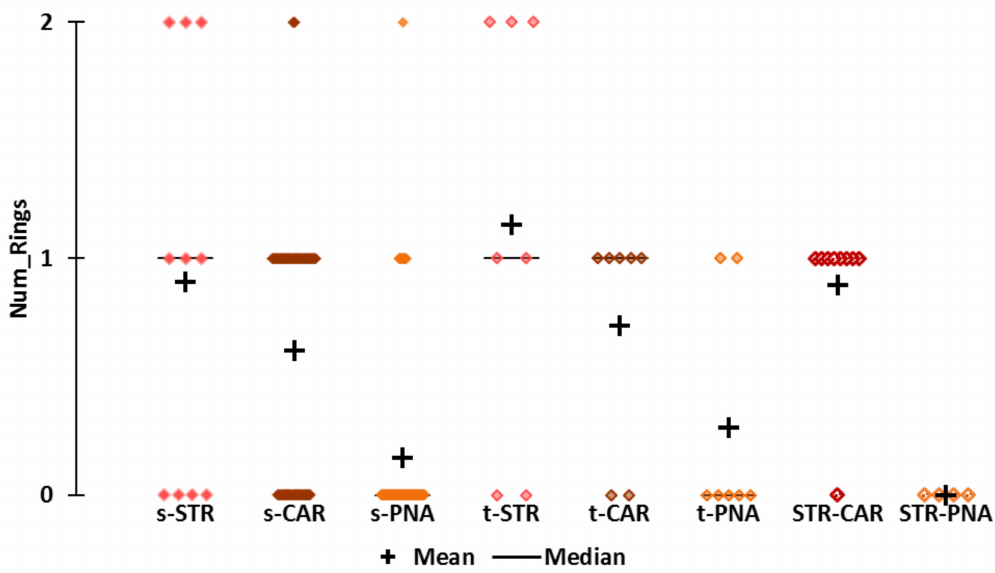
Figure 7. Scattergrams of the number of rings (Num_Rings) by odor